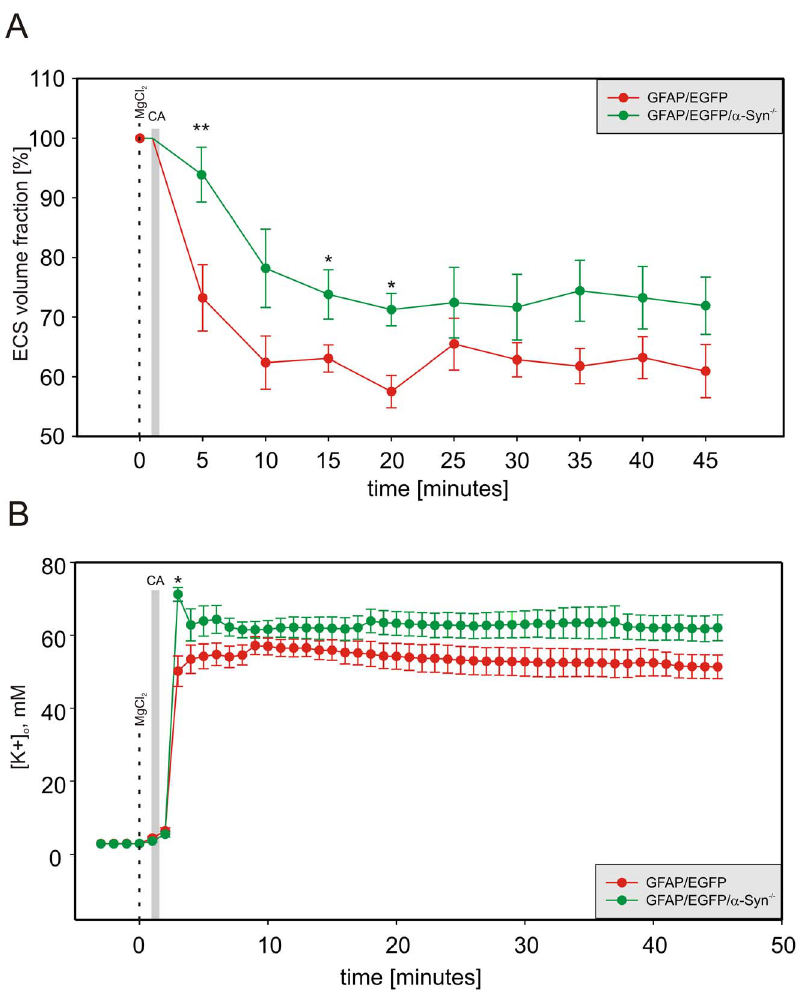
Figure 3. Relative changes in the ECS volume fraction and [K + ] o evoked by terminal ischemia/anoxia in vivo . Each data point represents mean ¡ S.E.M, calculated at 5 min intervals for ECS volume changes and each minute for [K + ] o changes. The relative changes in the values of the ECS volume fraction a ( A ) after the onset of terminal ischemia/anoxia were significantly smaller and slower in GFAP/EGFP/ a -Syn 2 / 2 mice than in GFAP/EGFP controls, but the final values did not differ. In contrast, the steep rise in [K + ] o levels ( B ) was higher and faster in GFAP/EGFP/ a -Syn 2 / 2 mice compared to GFAP/EGFP animals, with no difference in the final values. The gray bar indicates cardiac arrest (CA) and the dashed line indicates MgCl 2 injection. Asterisks indicate significant (*, p , 0.05) and very significant (**, p , 0.01) differences between GFAP/EGFP and GFAP/ EGFP/ a -Syn 2 / 2